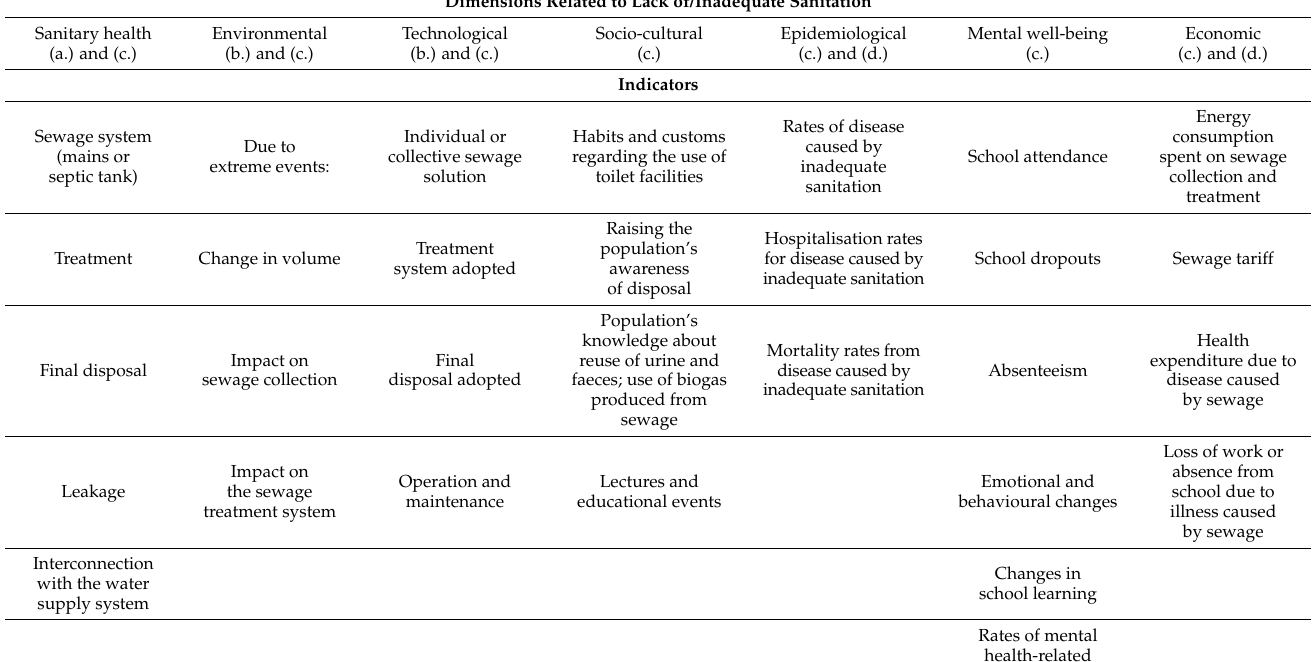
Table 3. A summary of the dimensions and indicators related to the lack of, or inadequate man- agement of, sanitation used in the HIA showing impacts on health. Where (a.) to (d.) relate to the evaluation tools given in Section